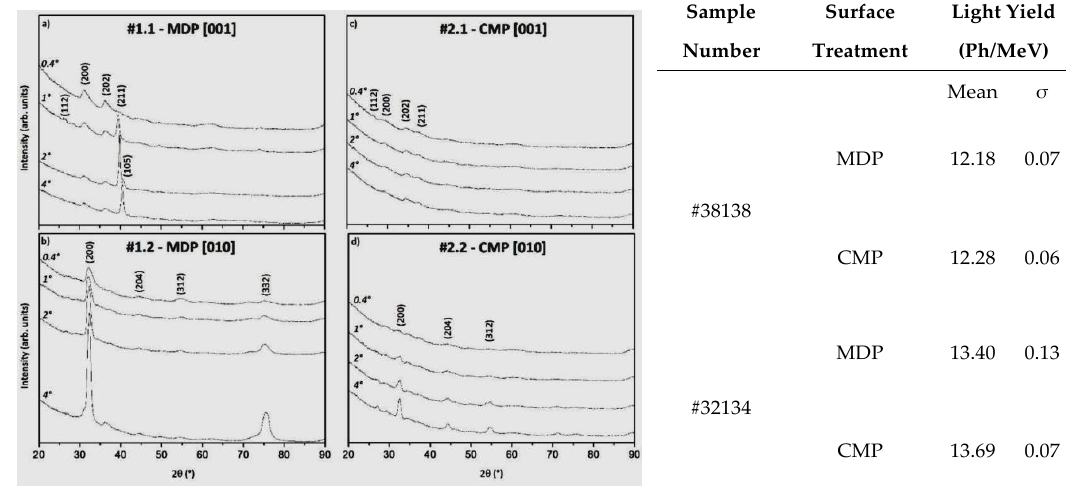
Figure 5. GID patterns (left side) at four different incidence angles (0.4°, 1°, 2°, and 4°) for PWO crystals submitted to MDP and CMP surface finishing. For each treatment, GID analysis was carried out on [001] and [010] crystallographically oriented surfaces. As clearly shown from the GID patterns, MDP maintains the PWO tetragonal structure on the surface, while CMP tends to amorphize the surface. Table 1 (right side) reports results of the light yield test, highlighting the positive contribution of CMP (chemical mechanical polishing) to crystal optical performance with respect to MDP (mechanical diamond polishing).